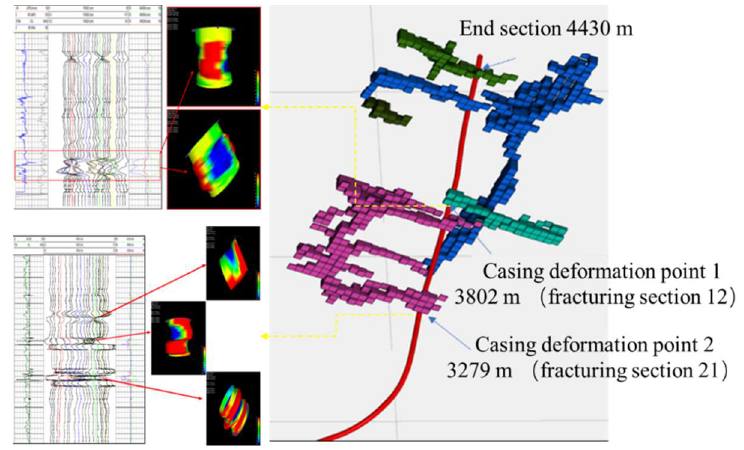
Figure 4. Distribution of casing deformation points.